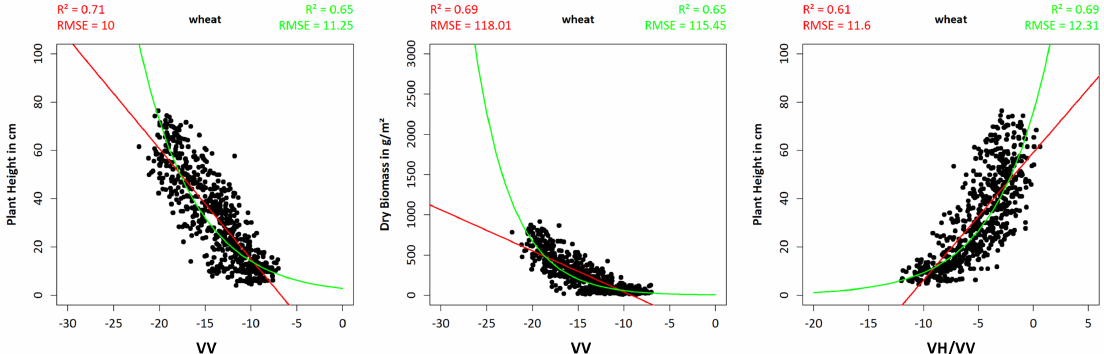
Figure 16. Scatter plots of plant height related to VV backscatter ( left ) and VH/VV ratio ( right ) and dry biomass related to VV backscatter ( center ) for BBCH stages 21–49. Regression lines, R 2 and RMSE are shown in red (linear) and green